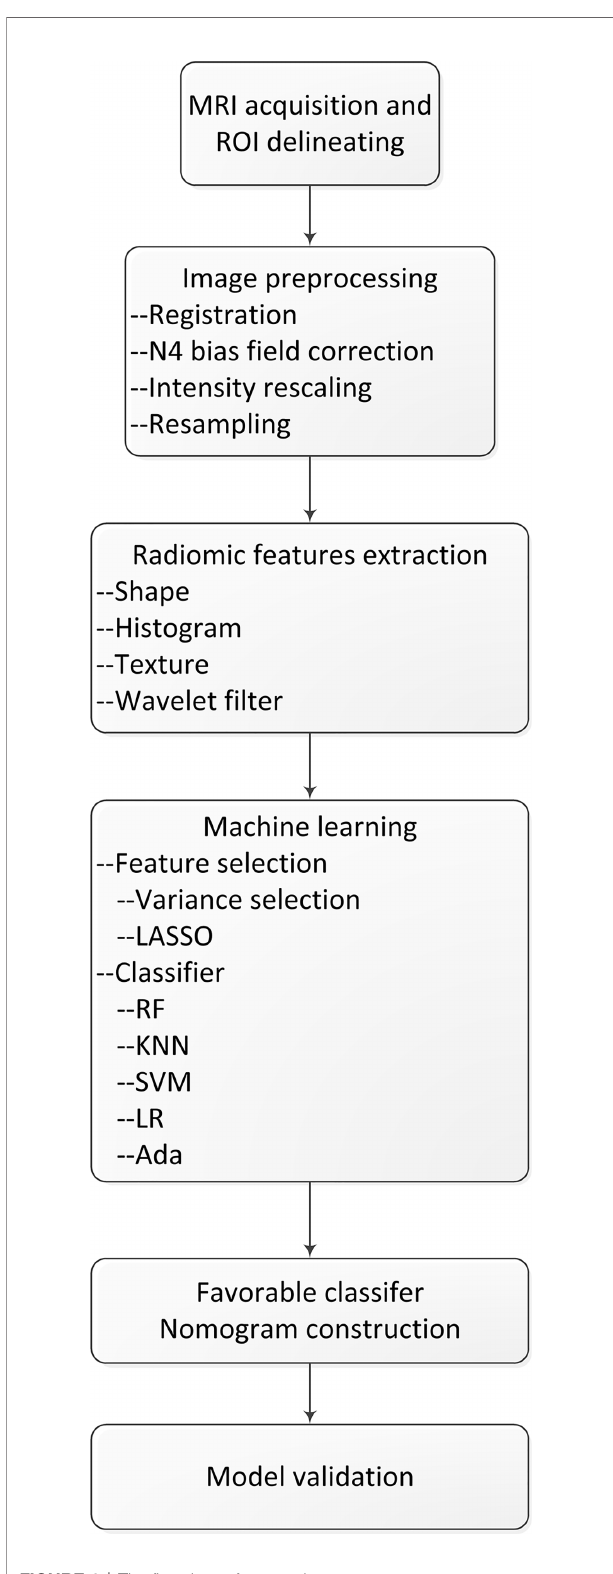
FIGURE 1 | The fl owchart of our